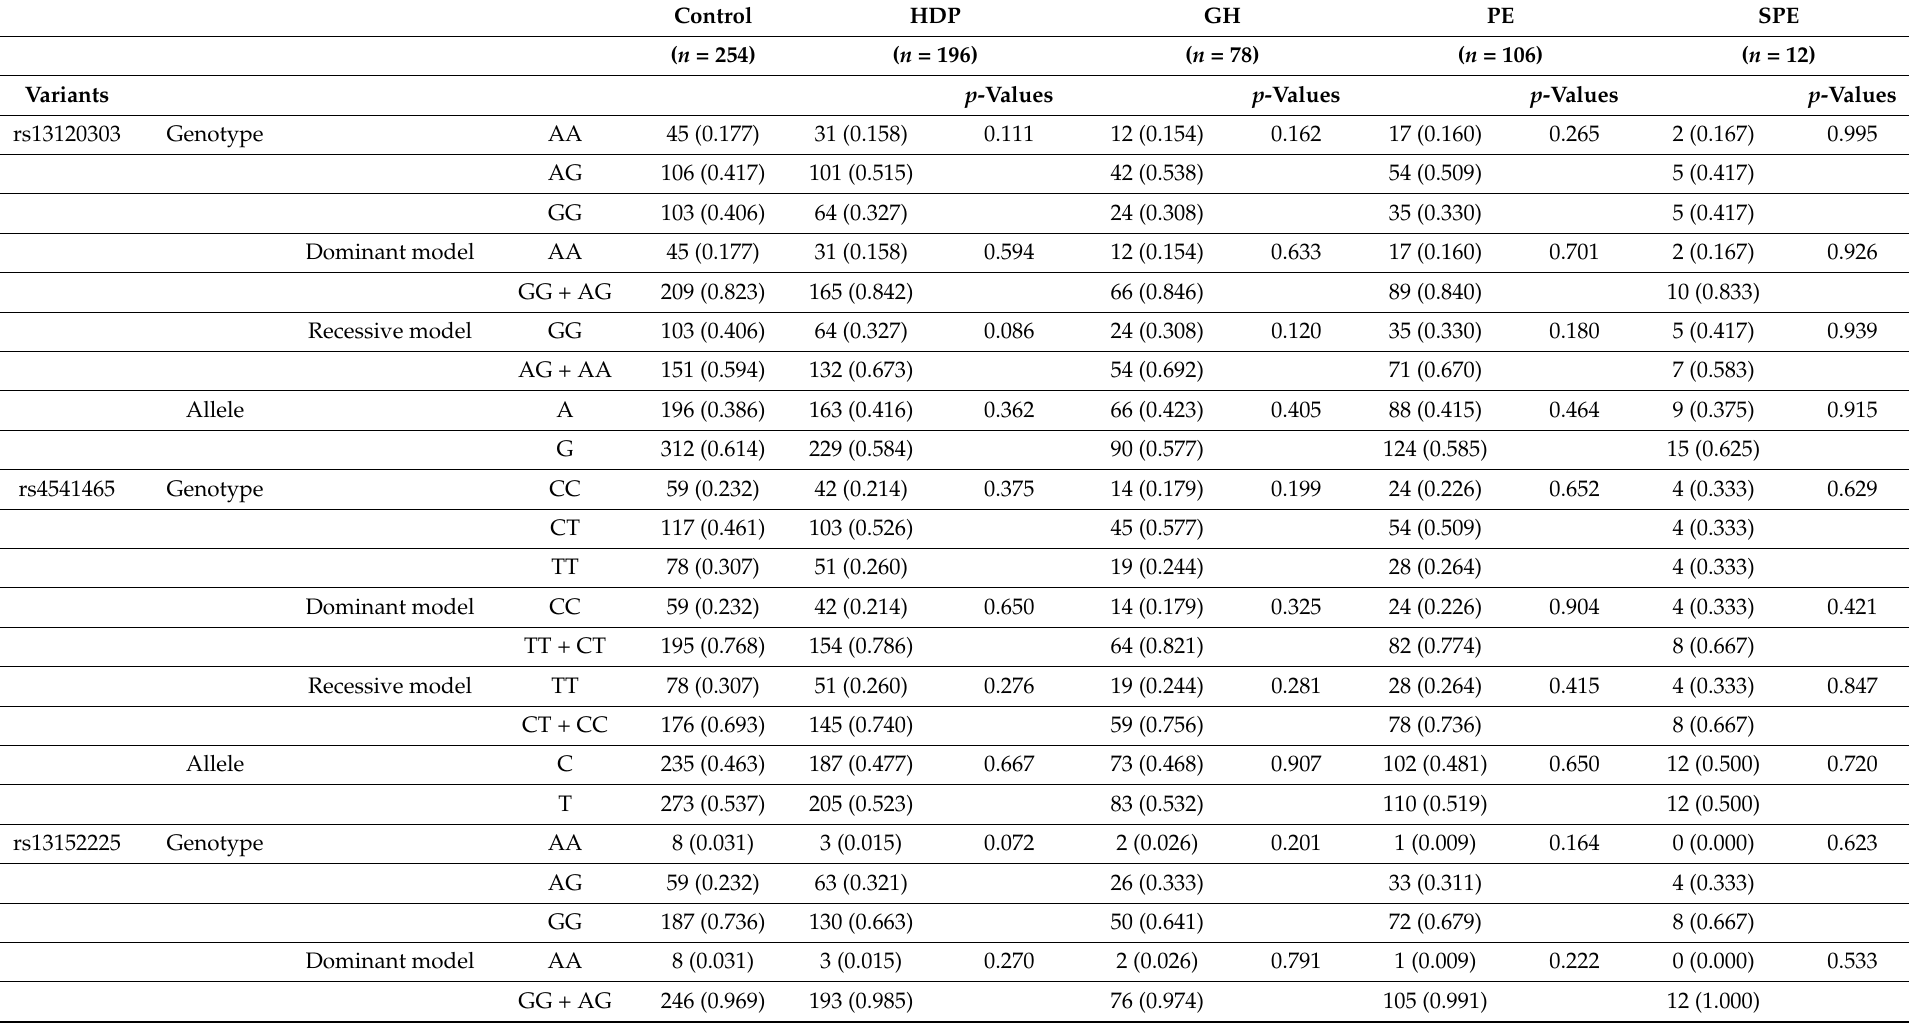
Table 3. Genotype and allele distributions among the control, HDP, GH, PE, and SPE